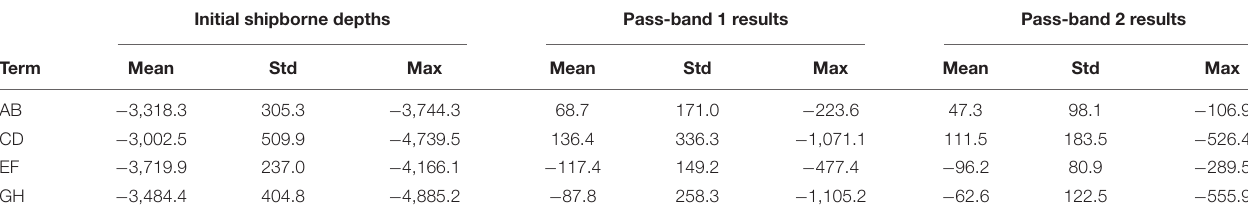
TABLE 7 | Depth statistics (unit:m).